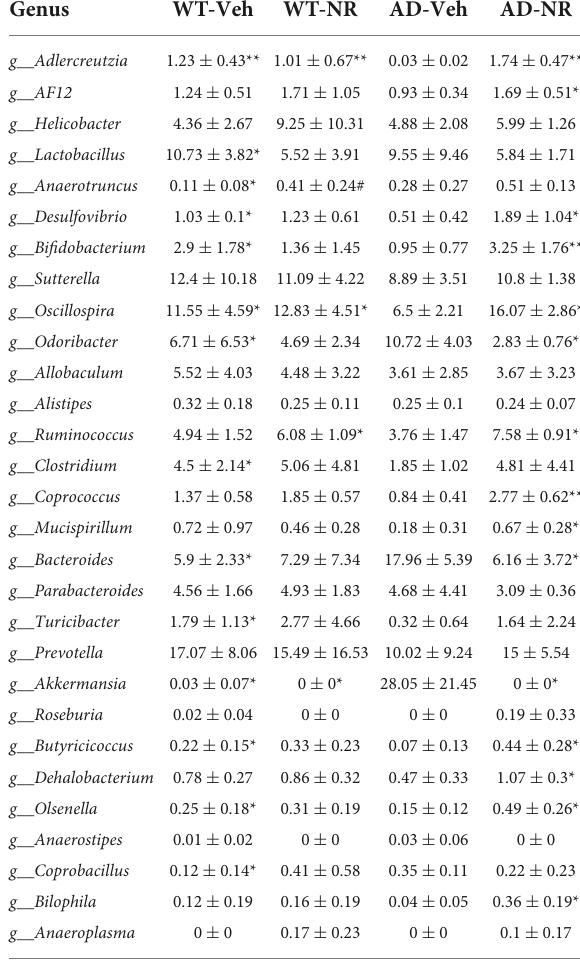
TABLE 1 The relative abundance (%) analysis at phylum level.